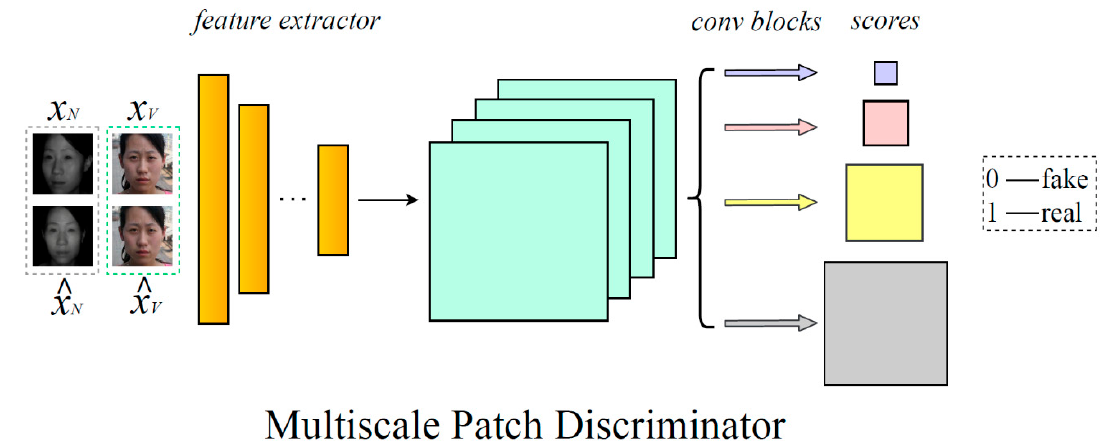
Figure 4. The architecture of the multiscale patch discriminator. The rectangle stands for the convolutional block in the feature extractor, and the arrowheads with different colors stand for the different convolutional blocks for getting final feature maps with different sizes.